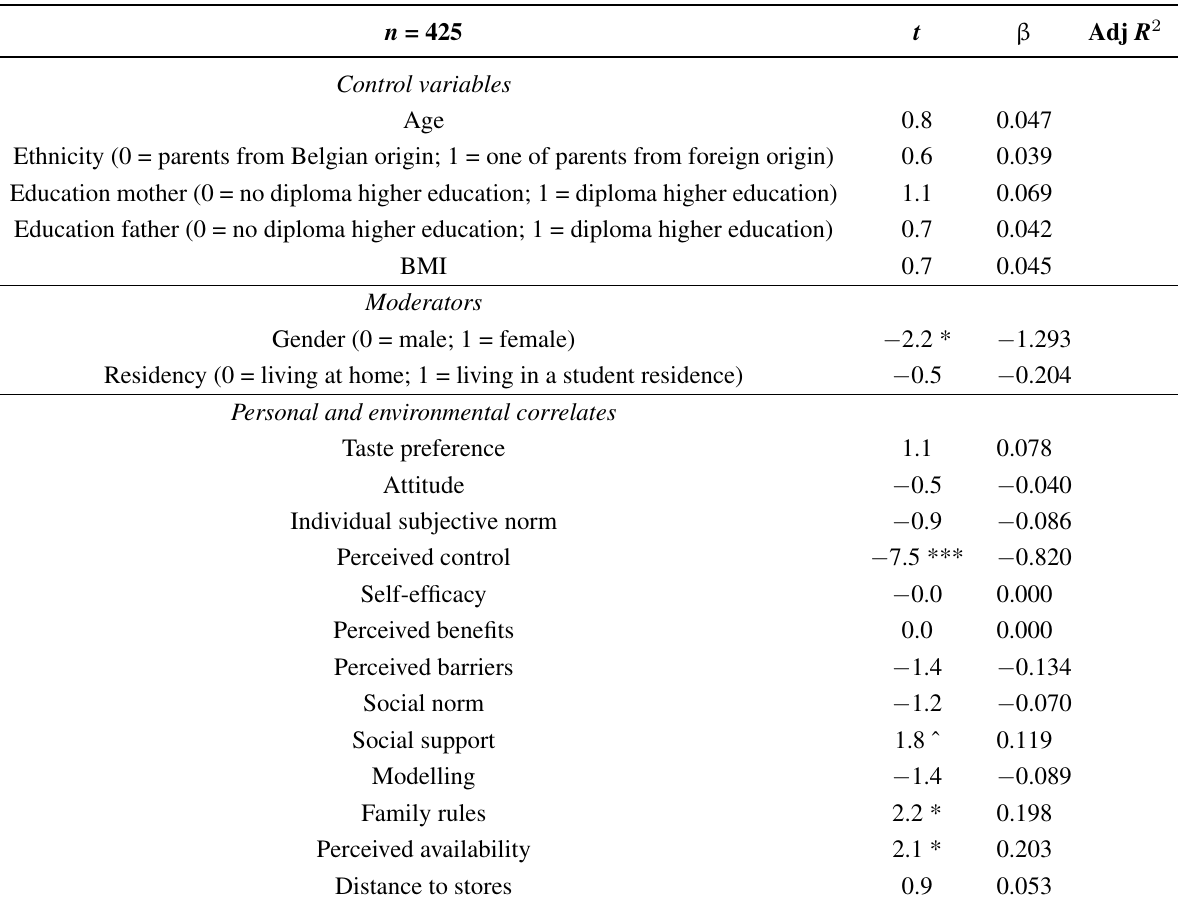
Table 4. Multivariate regression model of personal and environmental correlates of energy drink consumption in university students ( t -values, β -values, Adjusted R 2